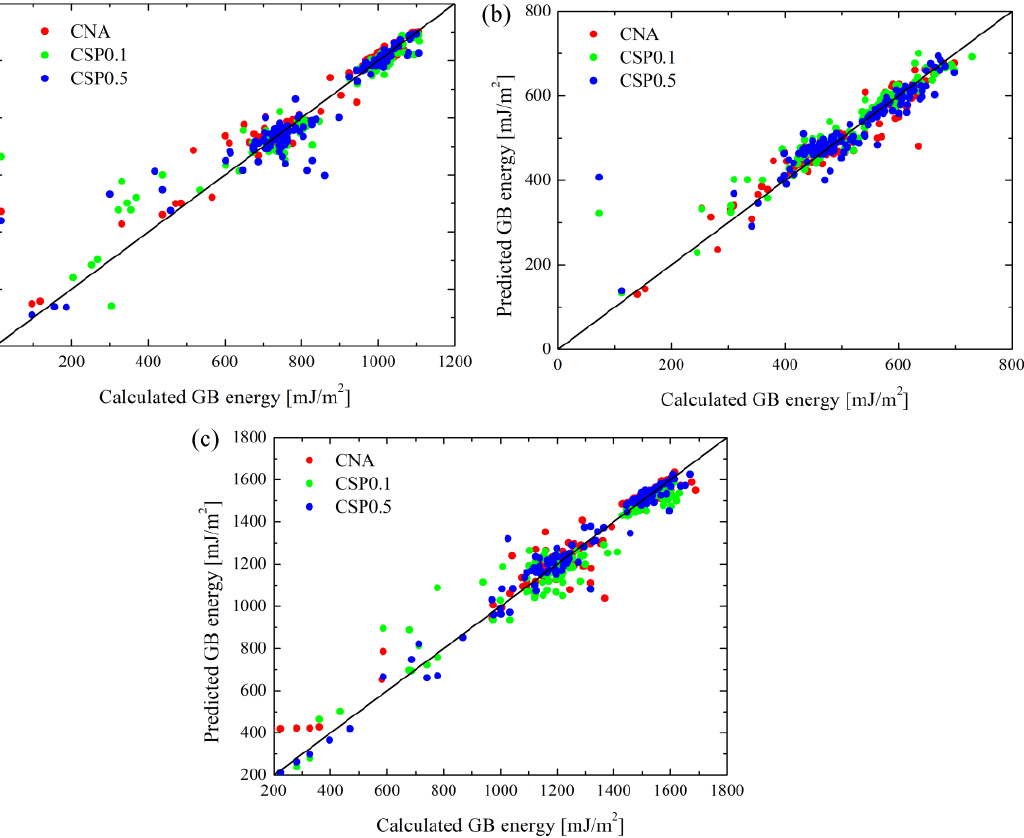
Figure 4. A comparison of RNN-based predictions and MD results for ( a ) Cu, ( b ) Al and ( c ) Ni. Note that predictions are made by considering the parameter ζ corresponding to the minimum MAE of three GB atom selection methods, as shown in Figure 5.